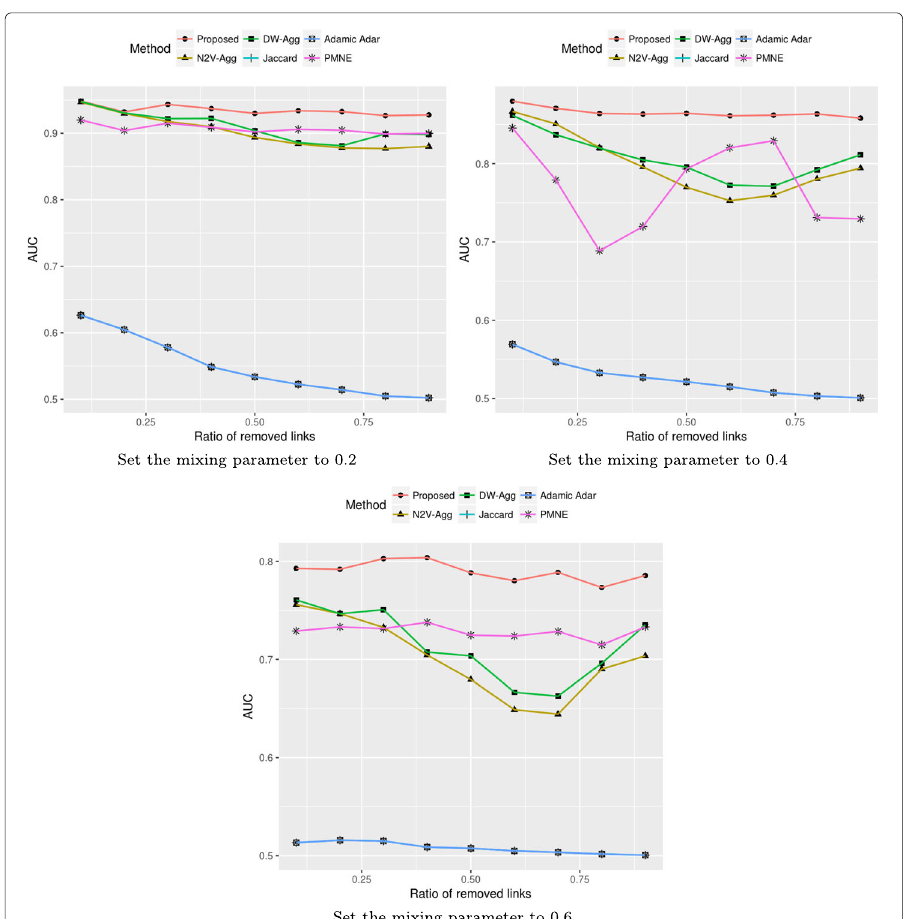
Fig. 4 Performance of the proposed model on different synthetic